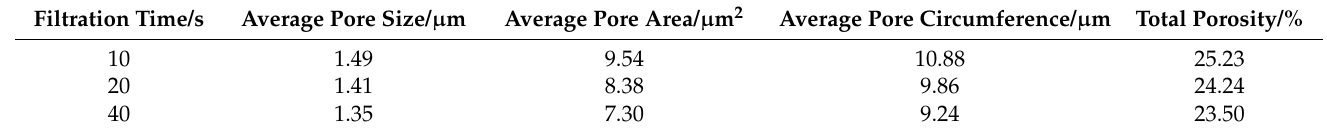
Table 2. Pore size of the filter cake at the different filtration times.